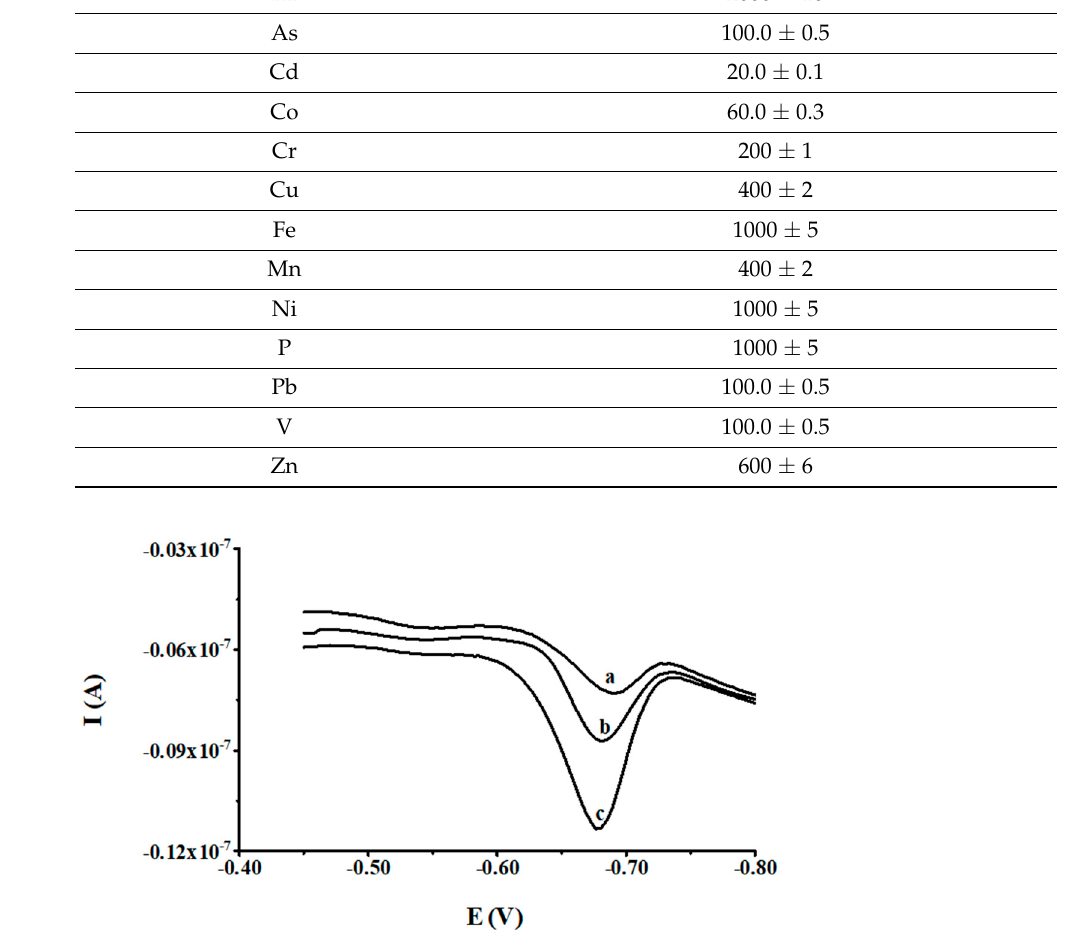
Figure 4. The AdSV voltammograms obtained during vanadium quantification in the certified ref- erence material SPS-WW1 waste water: SPS-WW1 diluted (1:200) (a) as (a) + 1 × 10 -8 mol L -1 V(V) (b) and as (a) + 2.5 × 10 -8 mol L -1 V(V)